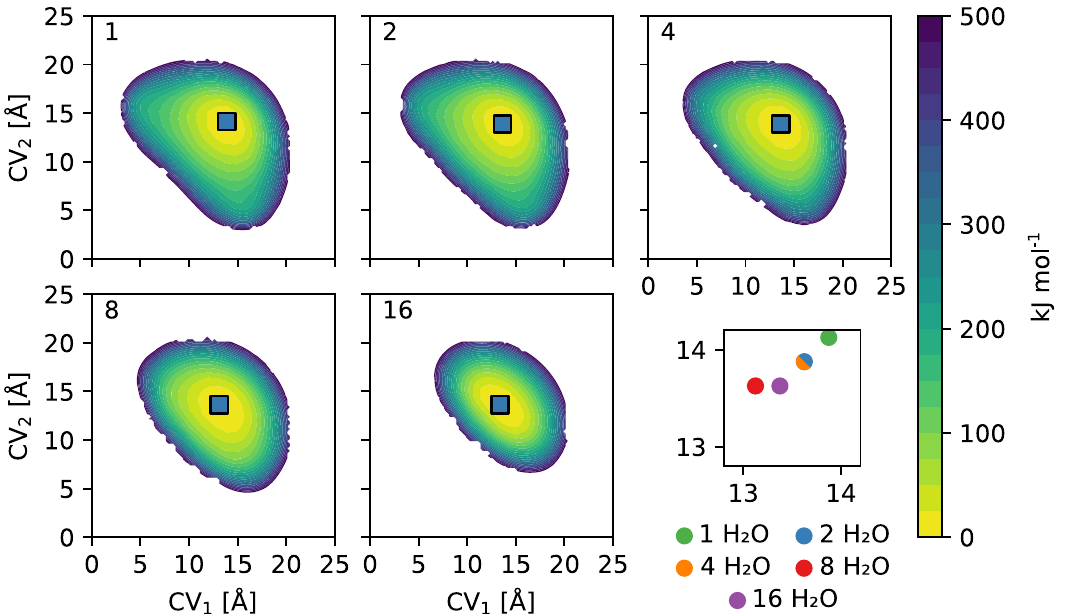
Fig. 6 Free energy surfaces for COF-300(7) at 300 K as a function of water loading. The water loading is exponentially varied from one to 16 molecules per channel, as indicated in the top left corner of each subpanel, with four channels per unit cell. The different (meta)stable phases are indicated in the fi gure. Regions with free energy exceeding the free energy minimum by more than 500 kJ mol − 1 are omitted from the plot, as they are not accessible under realistic conditions. The fi nal subpanel shows the exact position of the SQ phase for each loading in